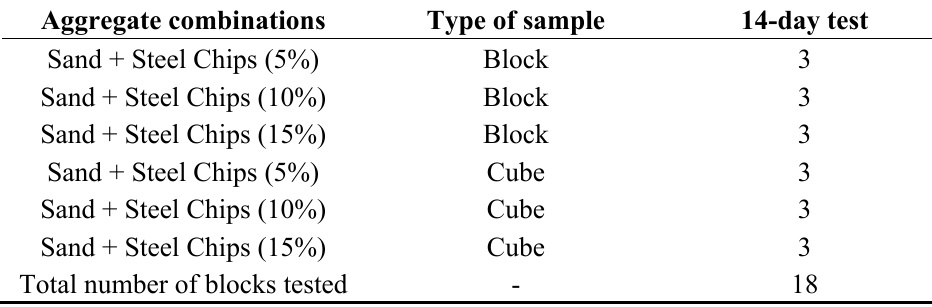
Table 3. Numbers of blocks and cubes for wet compressive strength